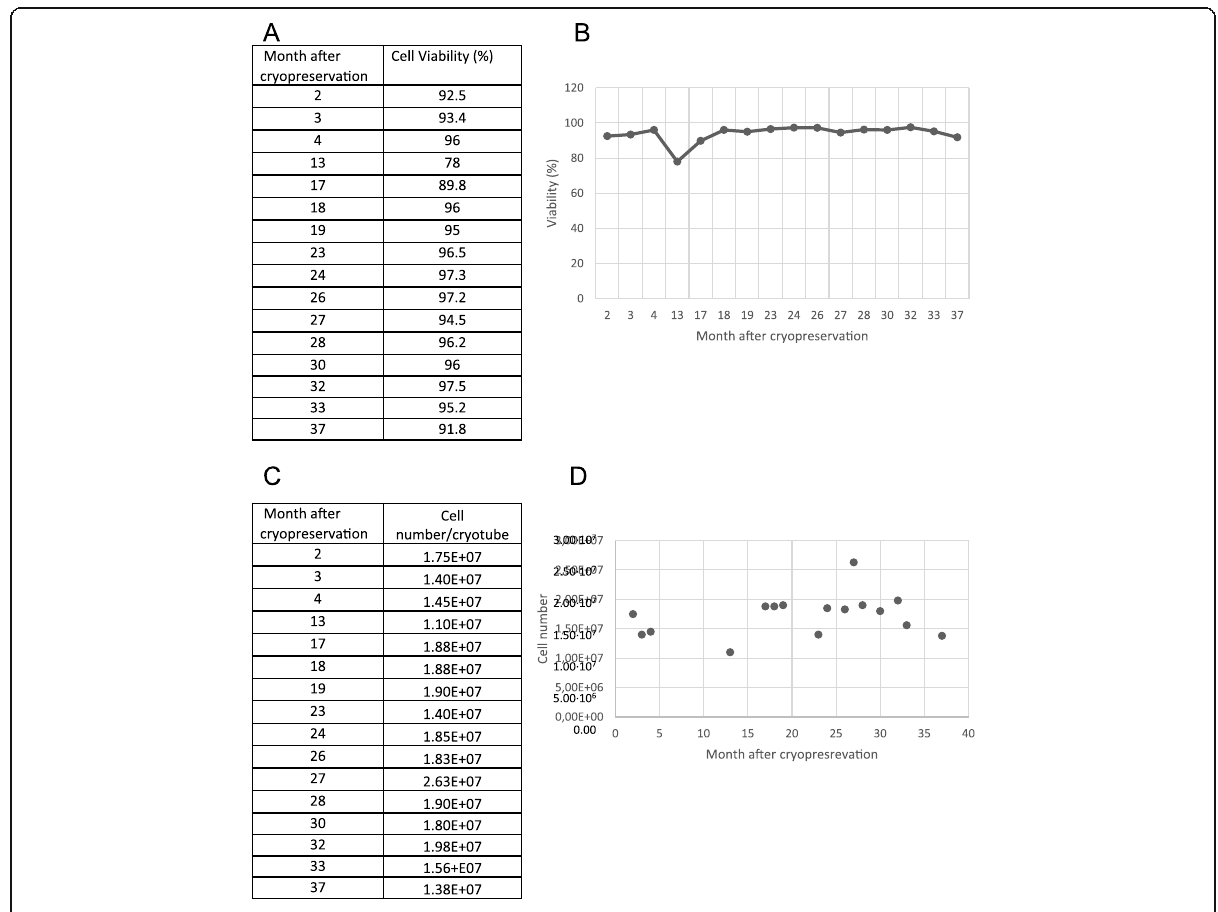
Fig. 3 Stability program of the WCB. Table ( a ) and graph ( b ) showing cell viability after thawing of WCB over a period of 37 months after cryopreservation. Table ( c) and graph ( d ) showing cell number after thawing of WCB over a period of 37 months after